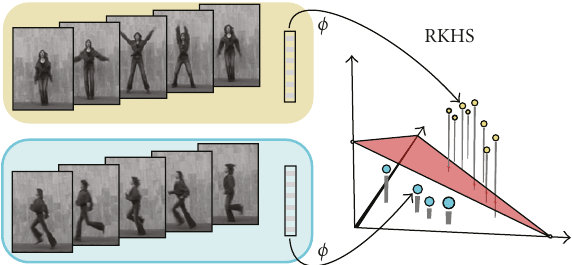
Figure 2: For supervised action recognition, for each sequence we compute a single feature vector (left) representing histogram- based data, as described in Section 6. Such feature vectors are then mapped to an RKHS by using a novel kernel which is both characteristic and appropriates for said representation (right). An SVD classifier is learnt from labeled training sequences in order to classify di ff erent